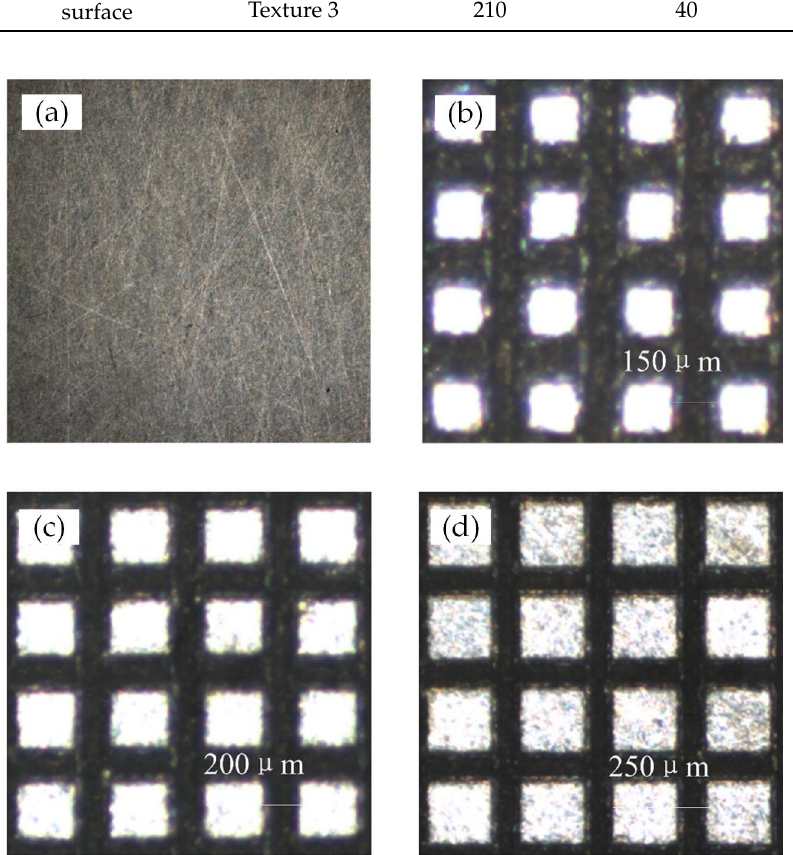
Figure 2. 2D profiles for different types of untreated or laser-treated surface: ( a ) smooth surface; ( b ) Textured surface 1; ( c ) Textured surface 2; and ( d ) Textured surface 3.